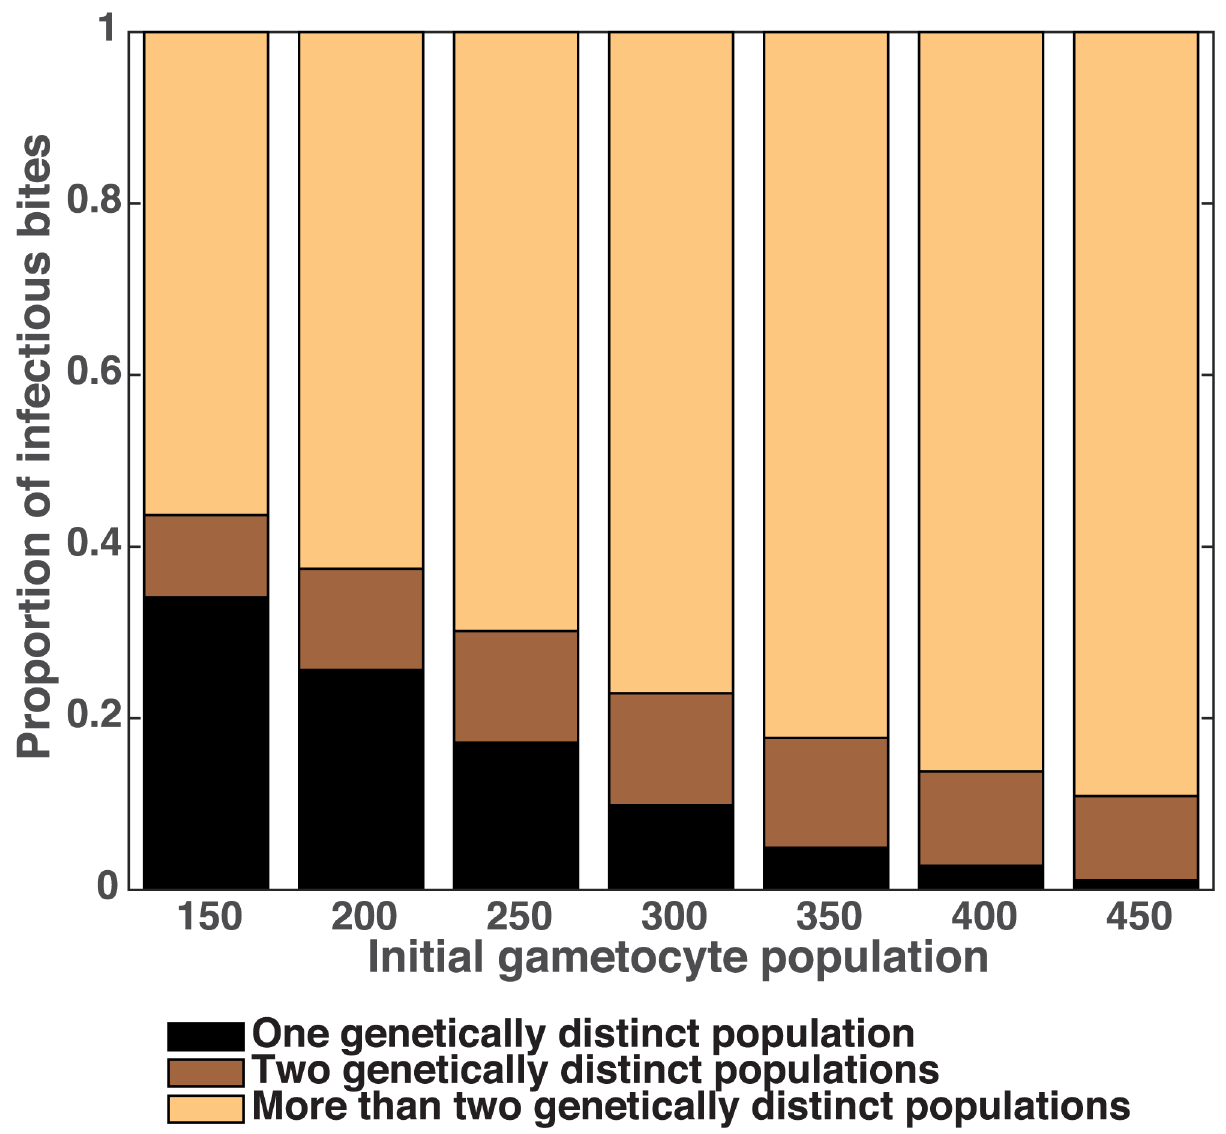
Fig 8. Frequency that multiple genetically distinct parasitesare passed in an infectious bite. The fraction of infectiousbites that harbor one (black), two (brown) or multiple (beige)parasiteswith distinct barcodesequences.When the mosquitois infected with a small number of gametocytes, 34% of infectiousbites are composed of a single sequence.At larger initial gametocyte numbers the proportionof infectiousbites passingonly a singlegeneticallydistinct parasitepopulationfalls to nearly 0. Ten sporozoites were assumed to be present in a single